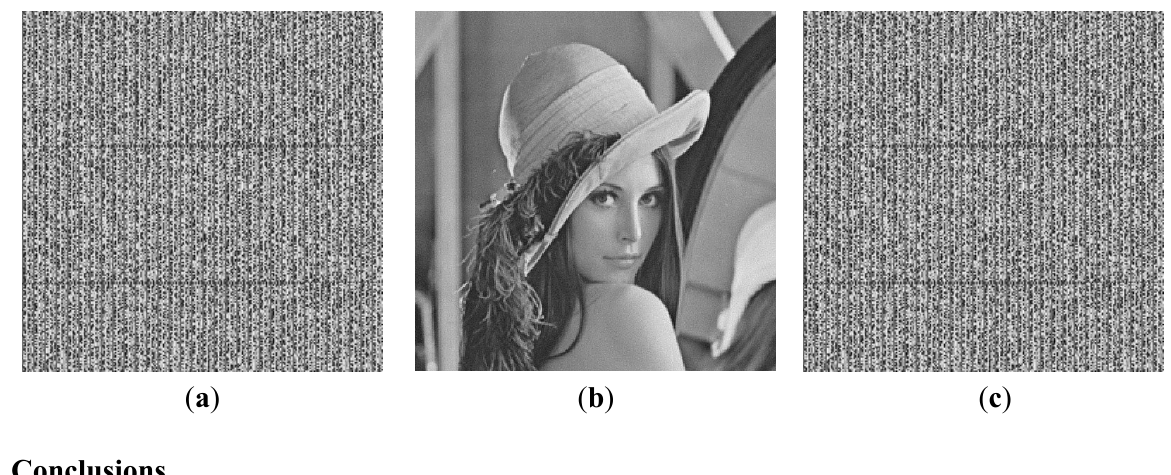
Figure 10. ( a ) The array transformed from the secret text with m = 4. ( b ) The image embedded with hidden data with α = 0.10. ( c ) The recovered transformed array. The recovery accuracy is